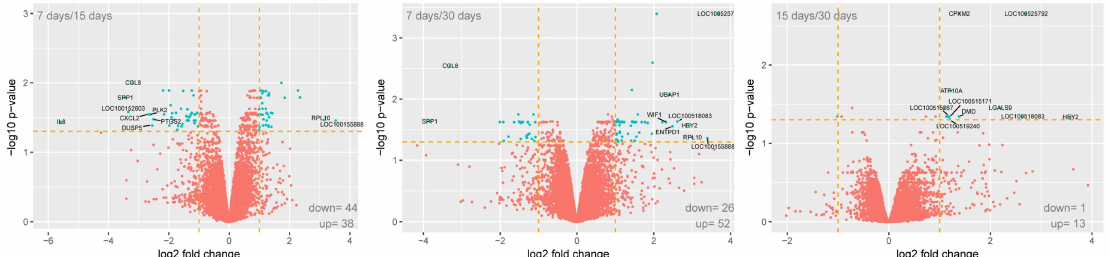
Figure 1. The Volcano plot representation between differently expressed genes between 7, 15, and 30 days of culture. The gene selection criteria were p -value beneath 0.05 and expression higher than two fold.